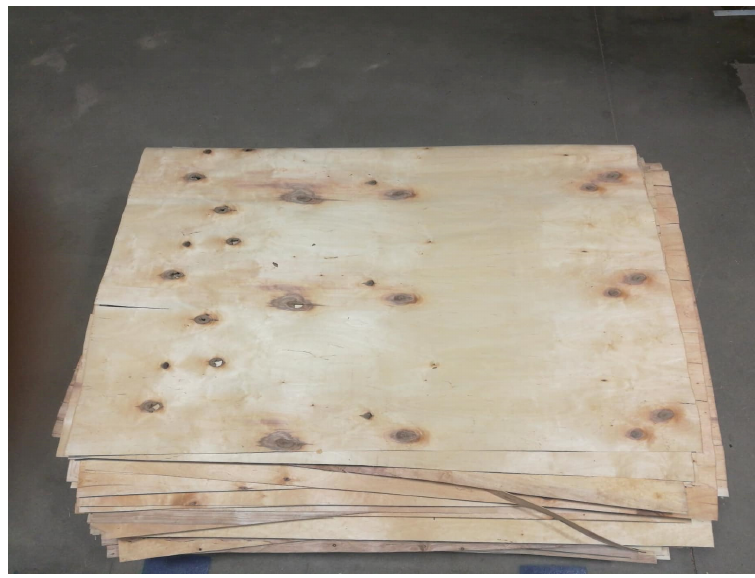
Figure 2. Example of wood veneer under study.